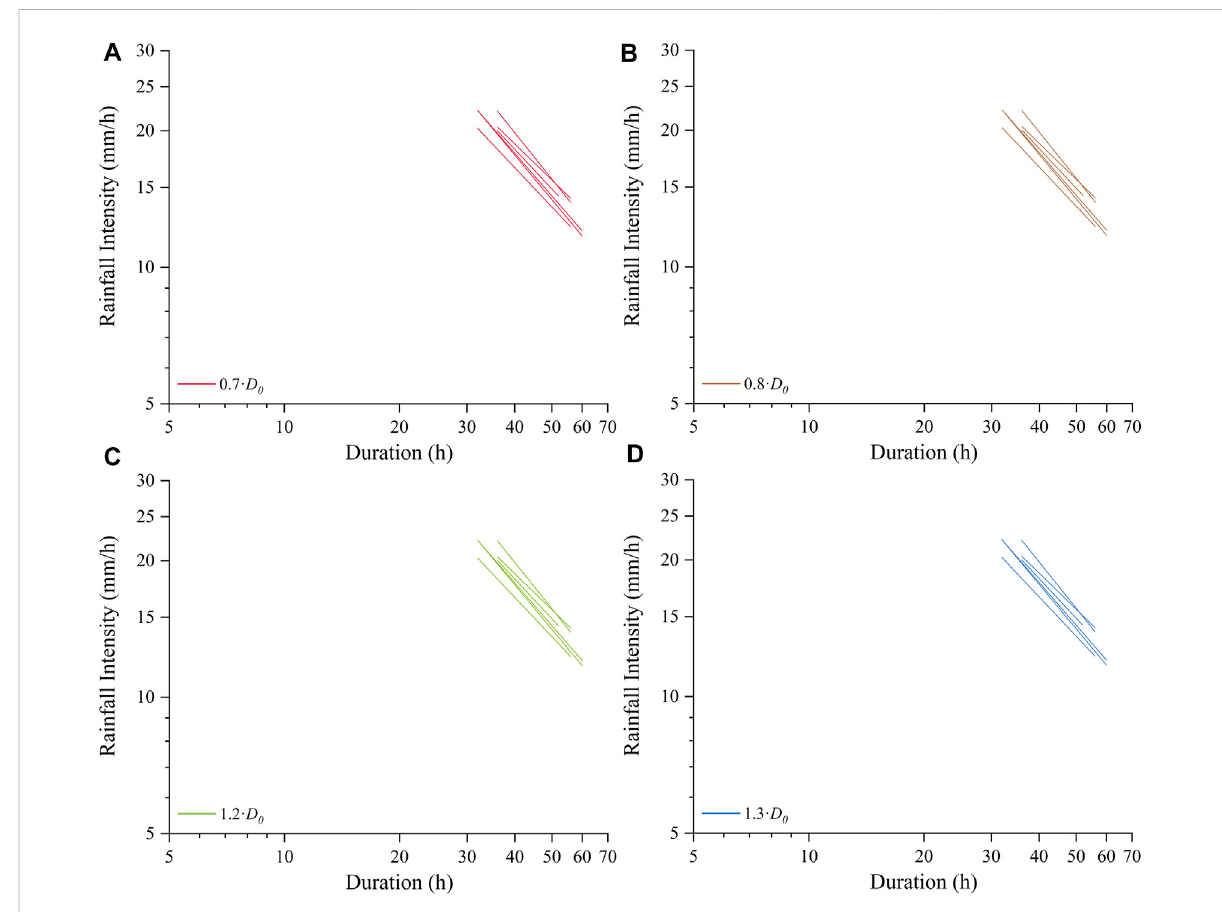
FIGURE 12 I-D thresholds de fi ned at the grid cell scale under the conditions: (A) 0.8 · D